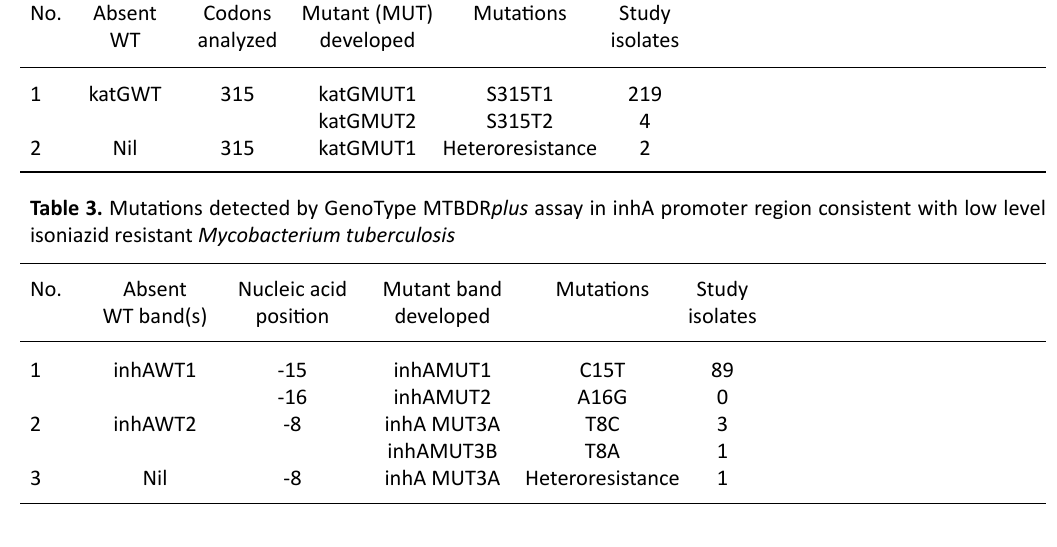
table 2. katG Mutation patterns by GenoType MTBDR plus assay No.